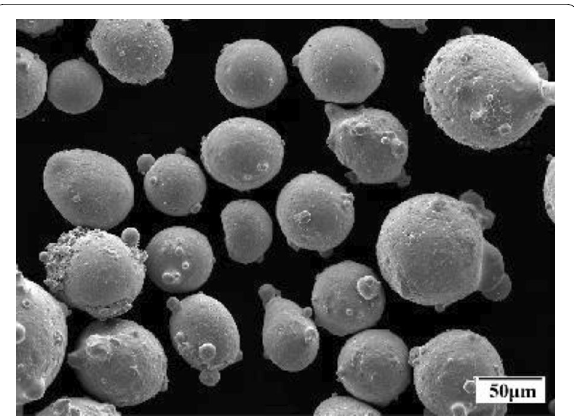
Figure 1 SEM image showing the morphology of NAB